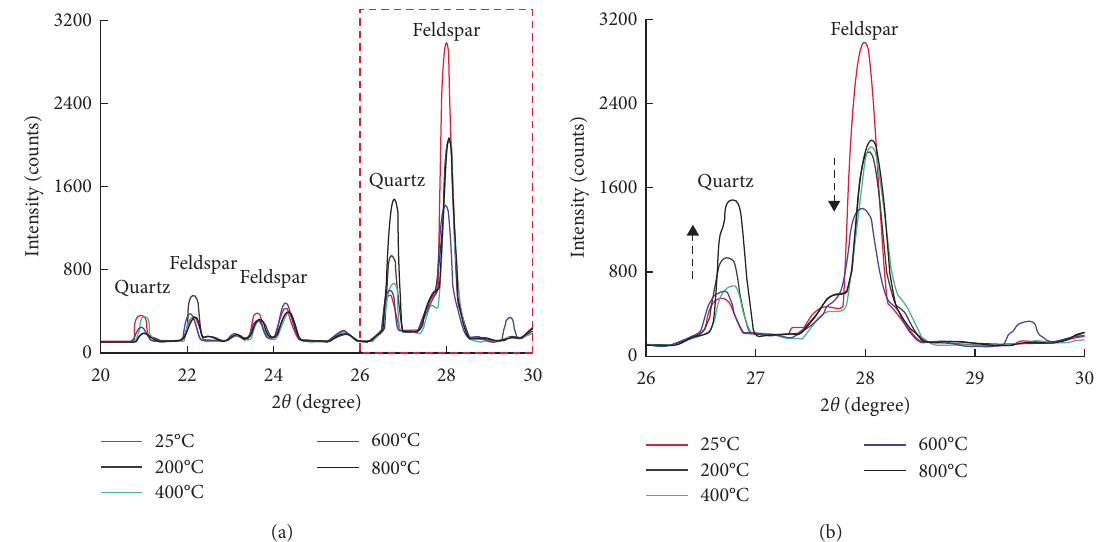
Figure 1: X-ray diffraction spectra for the powder of sandstone under various heat treatment temperatures [72, 73] (a) between the 2 θ angles of 20 ° and 30 ° and (b) between the 2 θ angles of 26 ° and 30 °